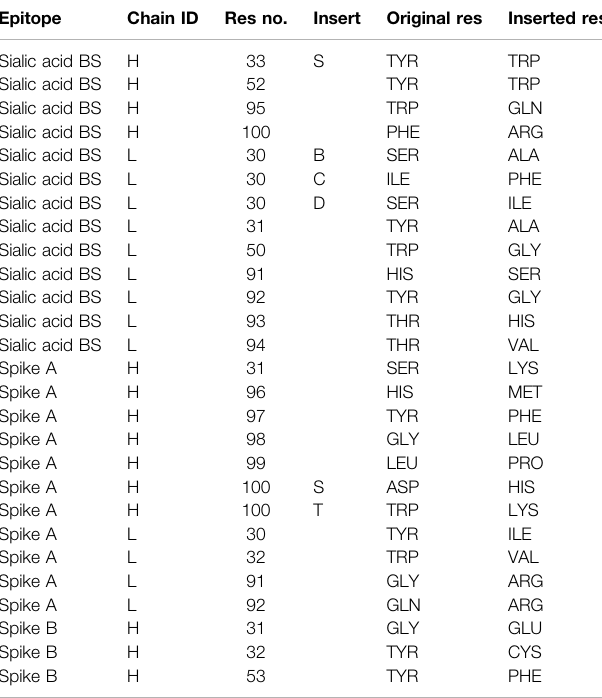
of residues having at least one atom closer than 4 of the molecular partner.